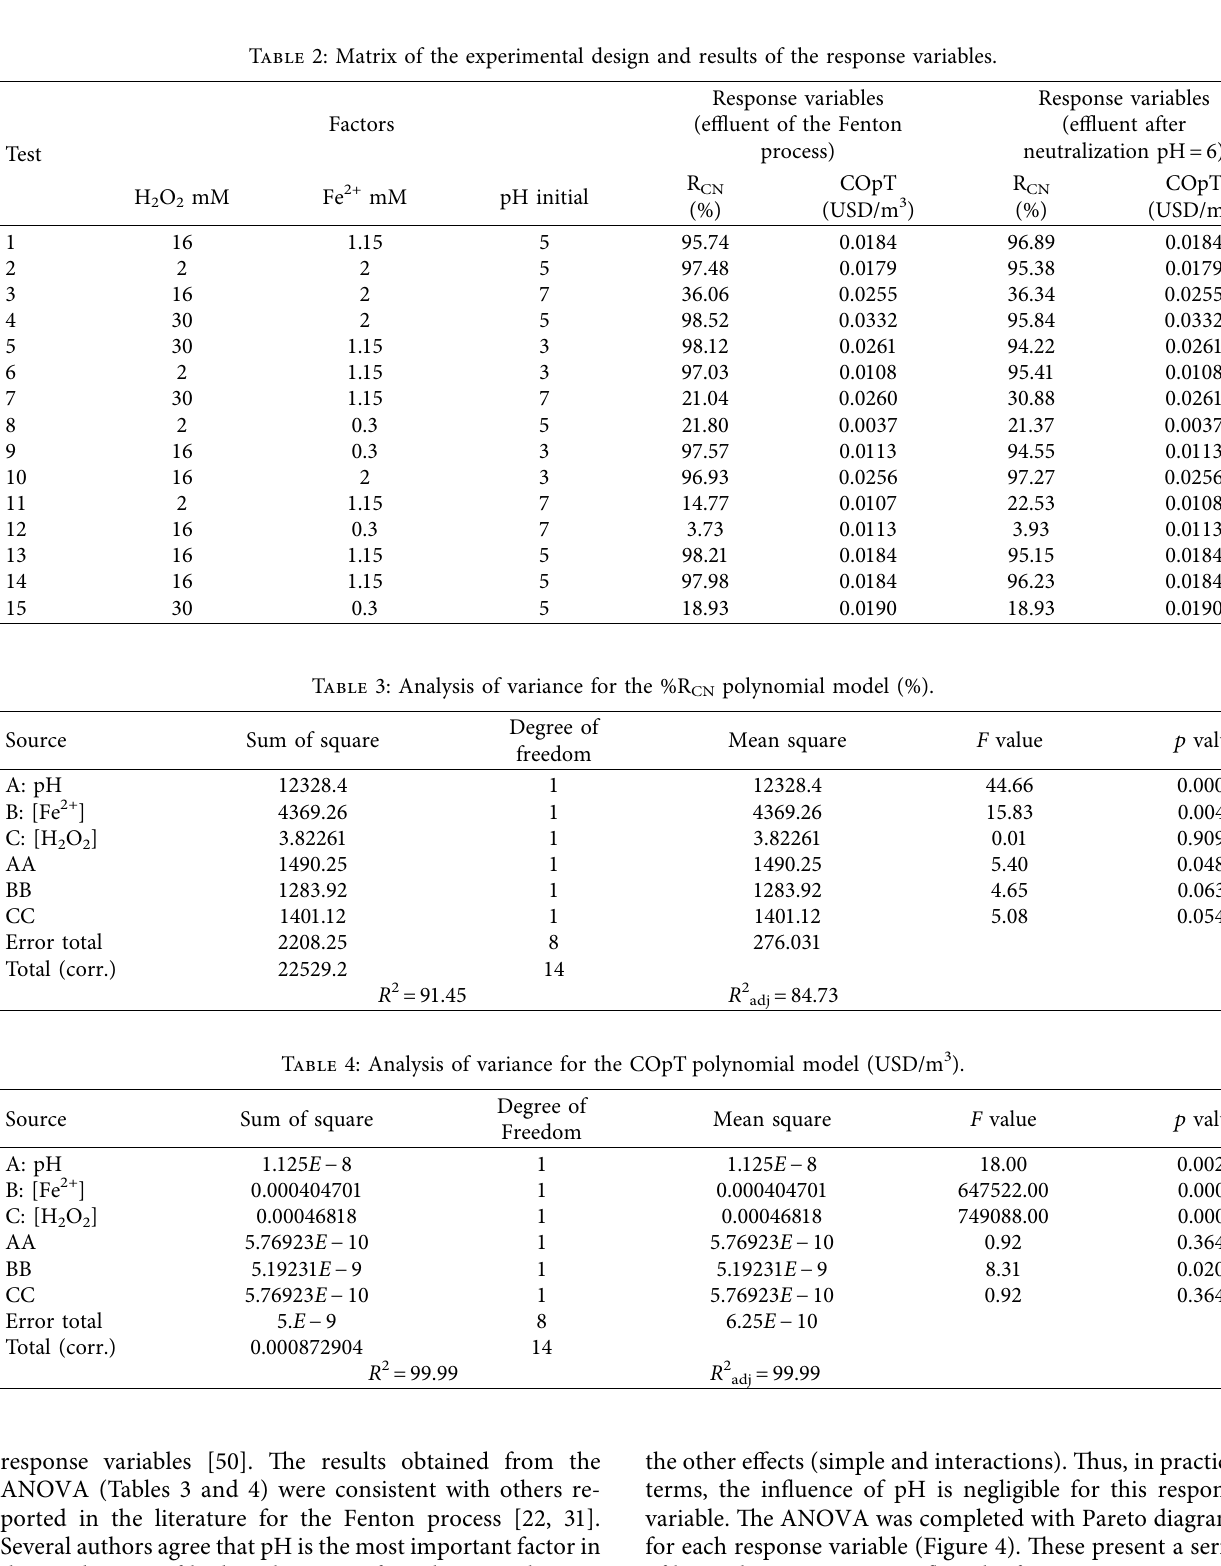
Table 2: Matrix of the experimental design and results of the response variables.